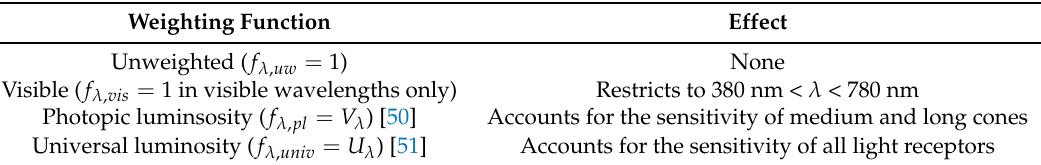
Table 2. Weighting functions.